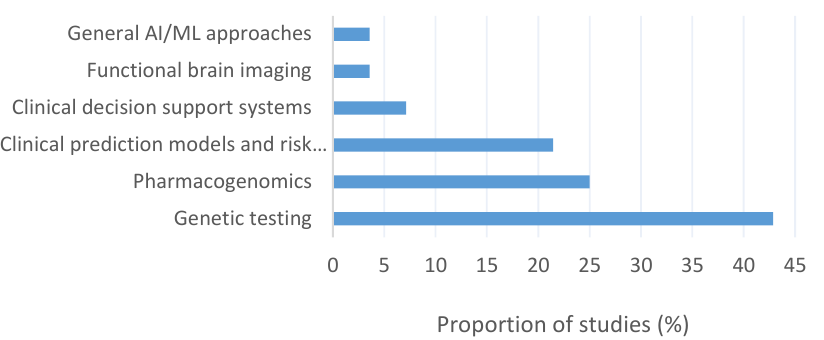
Figure 4. The precision psychiatry approaches adopted across the included literature and the proportion (%) of studies investigating each approach.